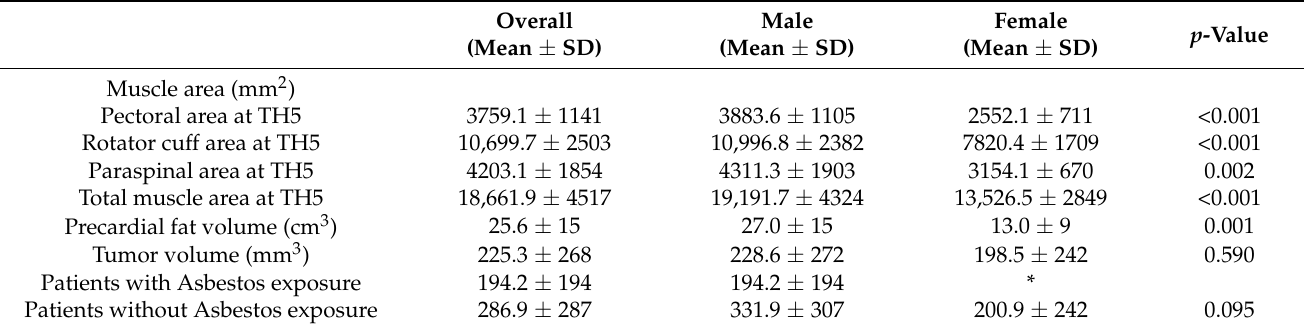
Table 1. Morphometric